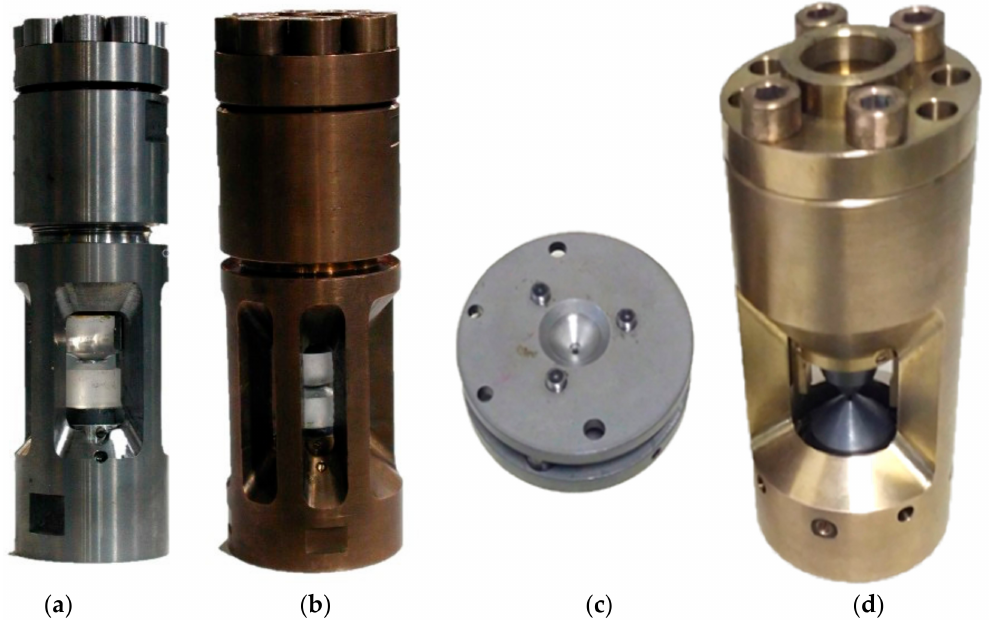
Figure 4. The high-pressure cells used on DN-6 diffractometer: ( a ) the steel high-pressure cell with sapphire anvils; ( b ) the beryllium-bronze six-column high-pressure cell with sapphire anvils; ( c ) standard Almax Plate diamond anvils cell (DAC); ( d ) wide-aperture